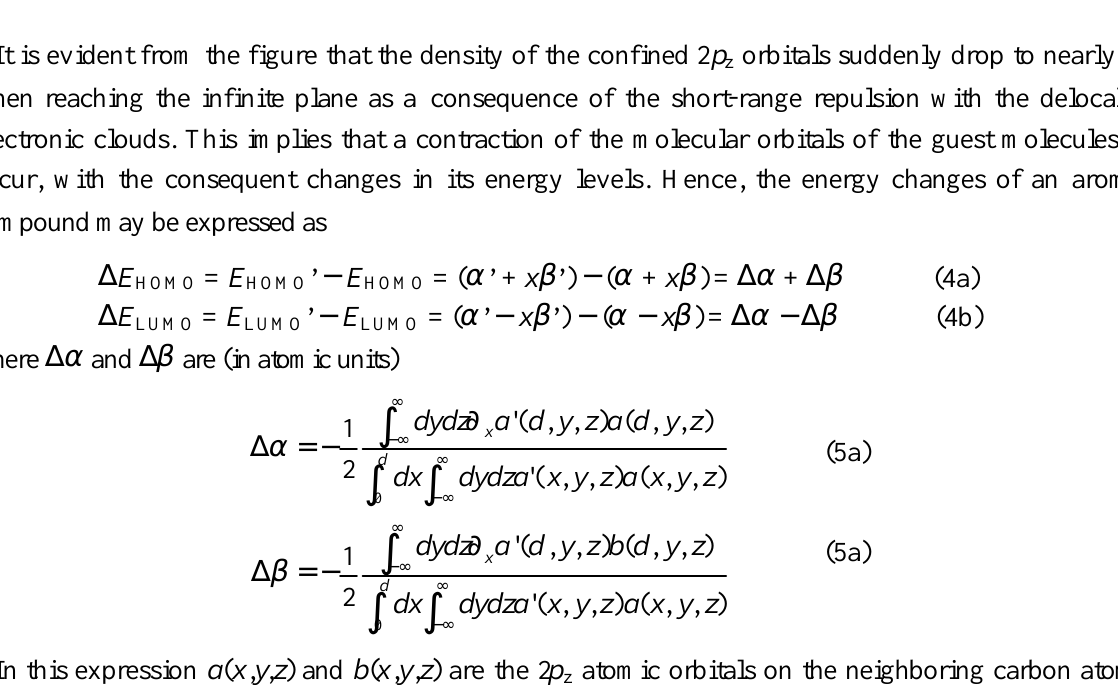
Figure 6: The schematic representation of the Y function of the conjugated molecule in unconfined (dashed line) and confined (solid line)